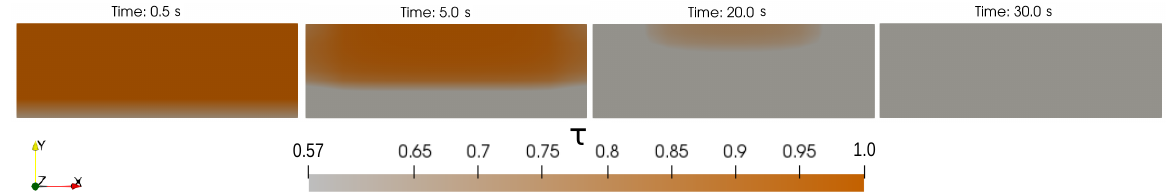
Figure 9. Advancement of pyrolysis of the wood log during the simulation. When τ = 1, no chemical reactions has still occurred. When τ = 0 all the pyrolysis mechanisms have taken place and only char is left in the material. At time t = 0.5 s it can be seen how the pyrolysis process starts from the bottom of the material and at time t = 30 s how all the material has been